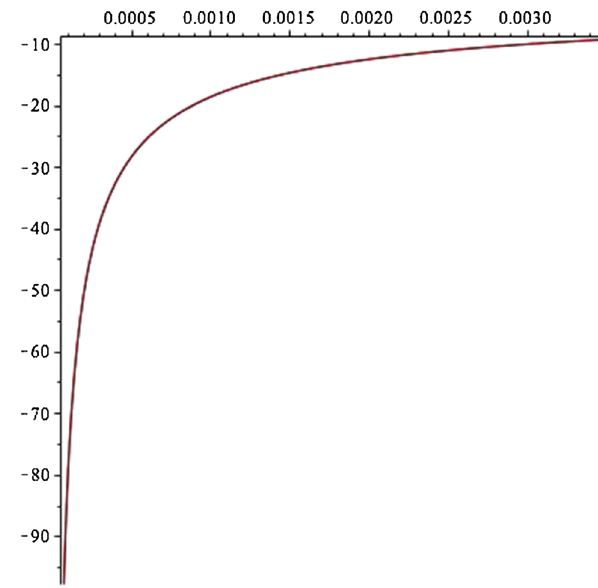
Fig. 3 This is a parametric plot for fidelity pressure and volume. This graph shows a fidelity-based equation of state as an attempt to find holographic version of